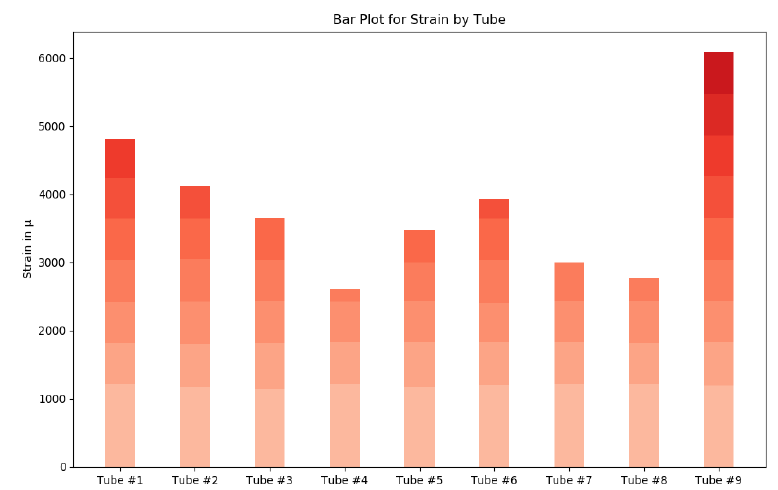
Figure 11. Description of the 10 stages of a tube’s degradation.